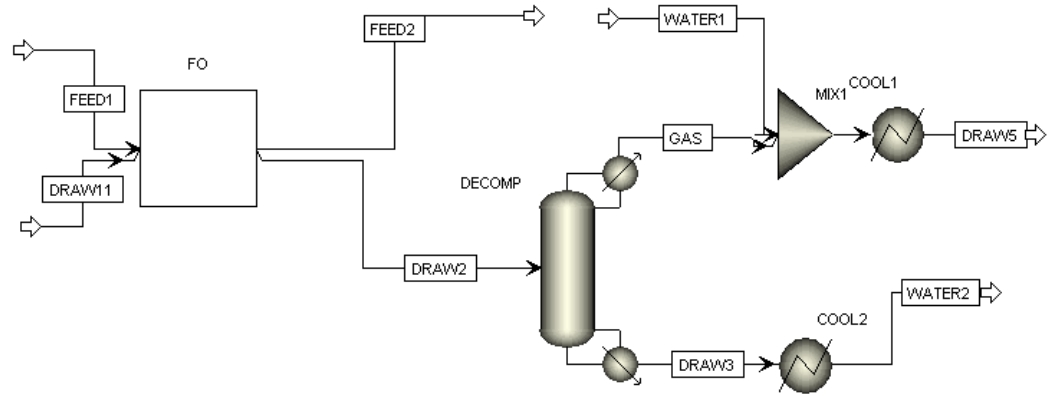
Figure 1. Aspen Plus flowsheet of the forward osmosis (FO) process using NH 3 -CO 2 as the draw solute.